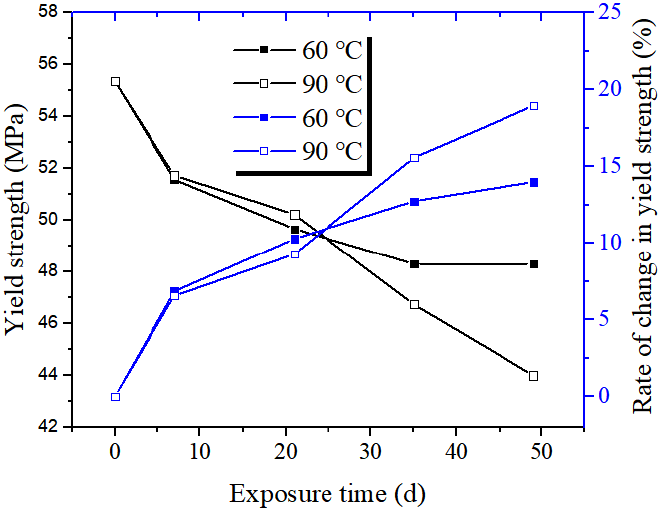
Figure 4. Yield strength and its change rate of PVDF samples at different exposure times.